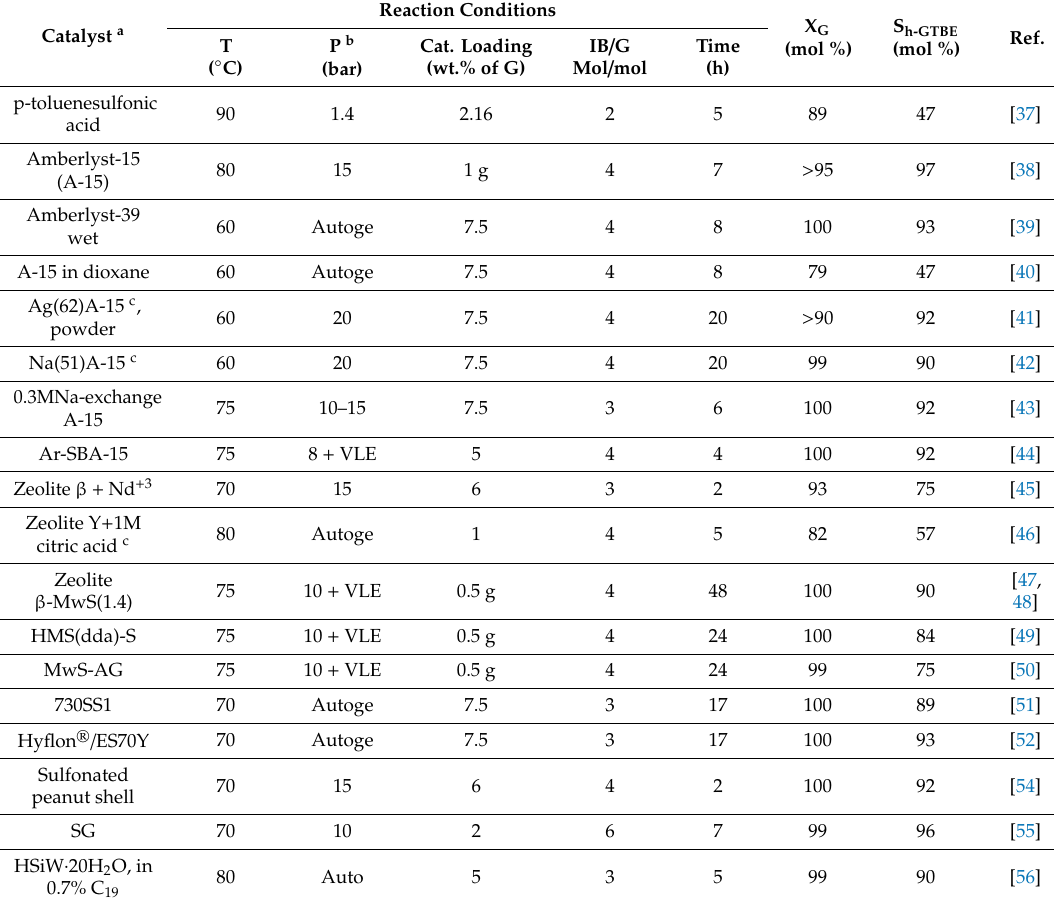
Reaction Conditions